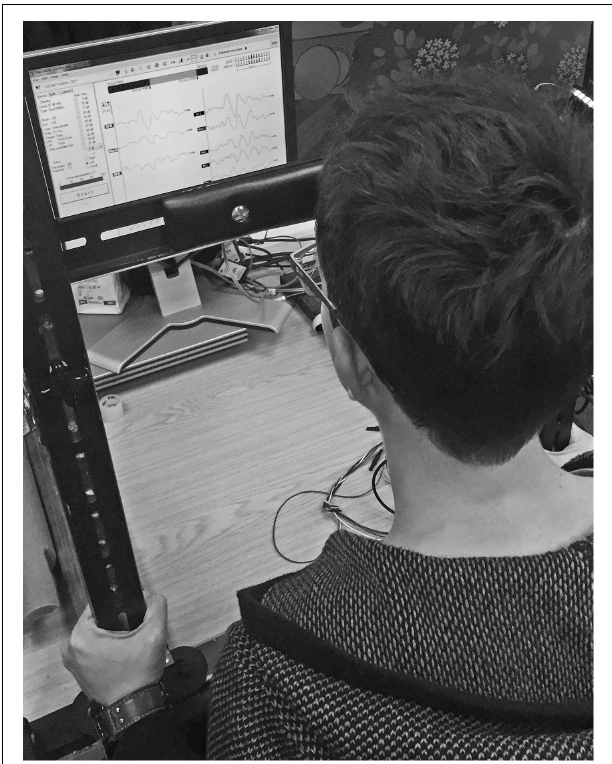
FIGURE 3 | Custom head bar. Participants were instructed to push against a padded bar using the forehead, such that sternocleidomastoid tension was maintained as close as possible to 50 µ V RMS throughout testing. Biofeedback in the Eclipse clinical software enabled participants to monitor sternocleidomastoid